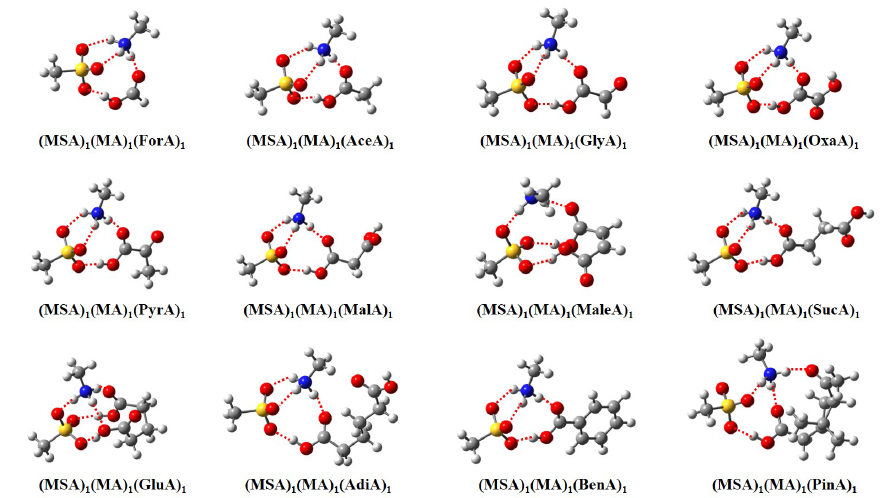
Figure 1. Lowest Gibbs free energy conformations of 12 (MSA) 1 (MA) 1 (OA) 1 clusters (OA is ForA, AceA, GlyA, OxaA, PyrA, MalA, MaleA, SucA, GluA, AdiA, BenA, and PinA) calculated at the ω B97X-D/6-31 ++ G(d , p) level of theory, at 298.15K and 1atm. The red balls represent oxygen atoms, the blue balls represent nitrogen atoms, the gray balls represent carbon atoms, and the white balls represent hydrogen atoms. The dashed red lines indicate hydrogen bonds.